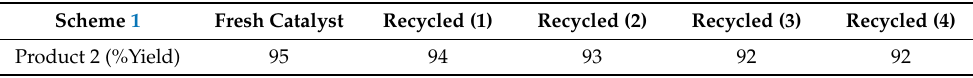
Table 1. Recyclability of the chitosan-aluminum oxide nanocomposite as base catalyst.